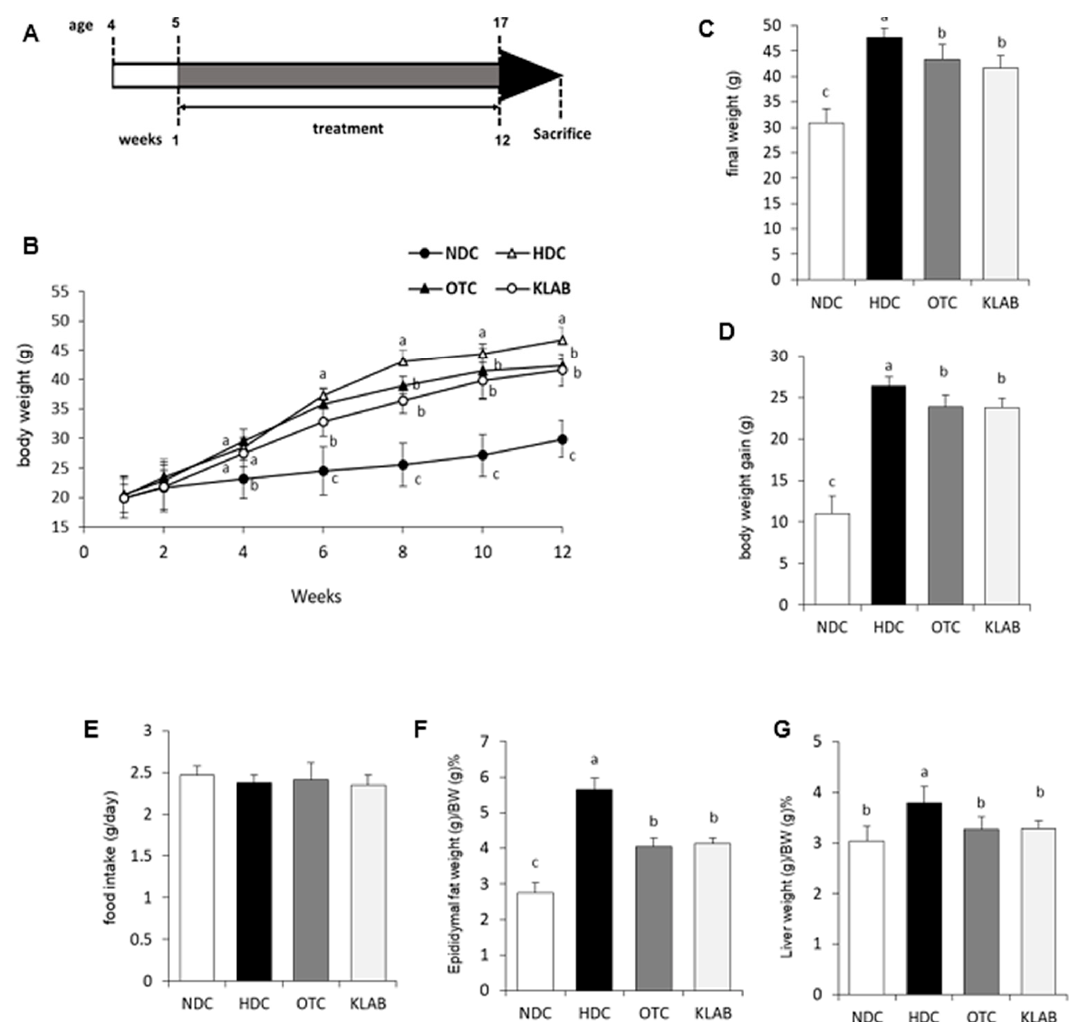
Figure 1. Scheme of experimental protocol, body weight and body composition of mice fed the experimental diet. Scheme of experimental protocol ( A ); growth curve ( B ); final weight ( C ); body weight gain ( D ); food intake ( E ); Epididymal fat weight (g)/BW (g) % ( F ); Liver weight (g)/BW (g) % ( G ). Results are Mean ± S.D of 10 mice per group. a-b-c; Values with different superscripts are significantly different by ANOVA with Duncan’s multiple range test at p < 0.05. NDC: Normal diet control; HDC: High fat diet control; OTC: high-fat diet plus L-ornithine 20 mg/kg; KLAB: High fat diet plus 1×10 9 CFU of L. brevis OPK-3 per mouse. one-way ANOVA, analysis of variance